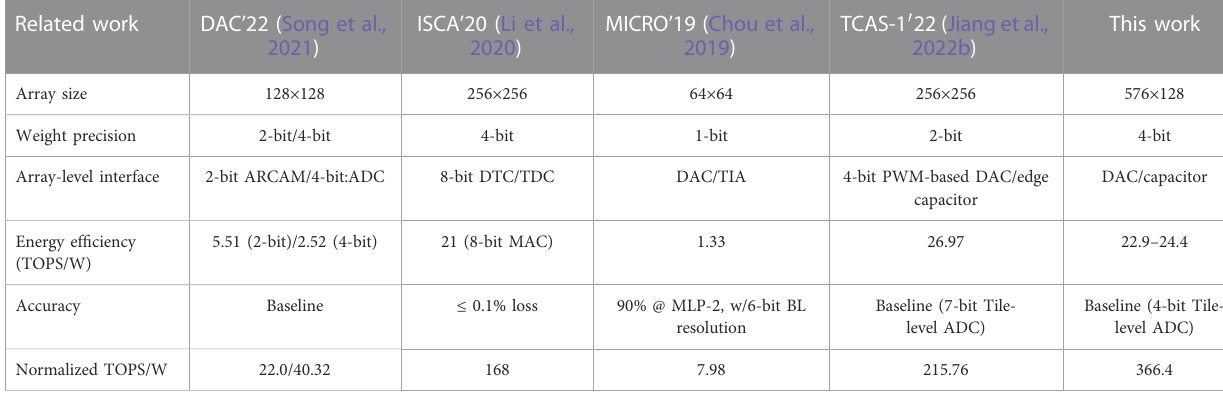
TABLE 3 Comparison table with recent RRAM-based CIM macros. Related